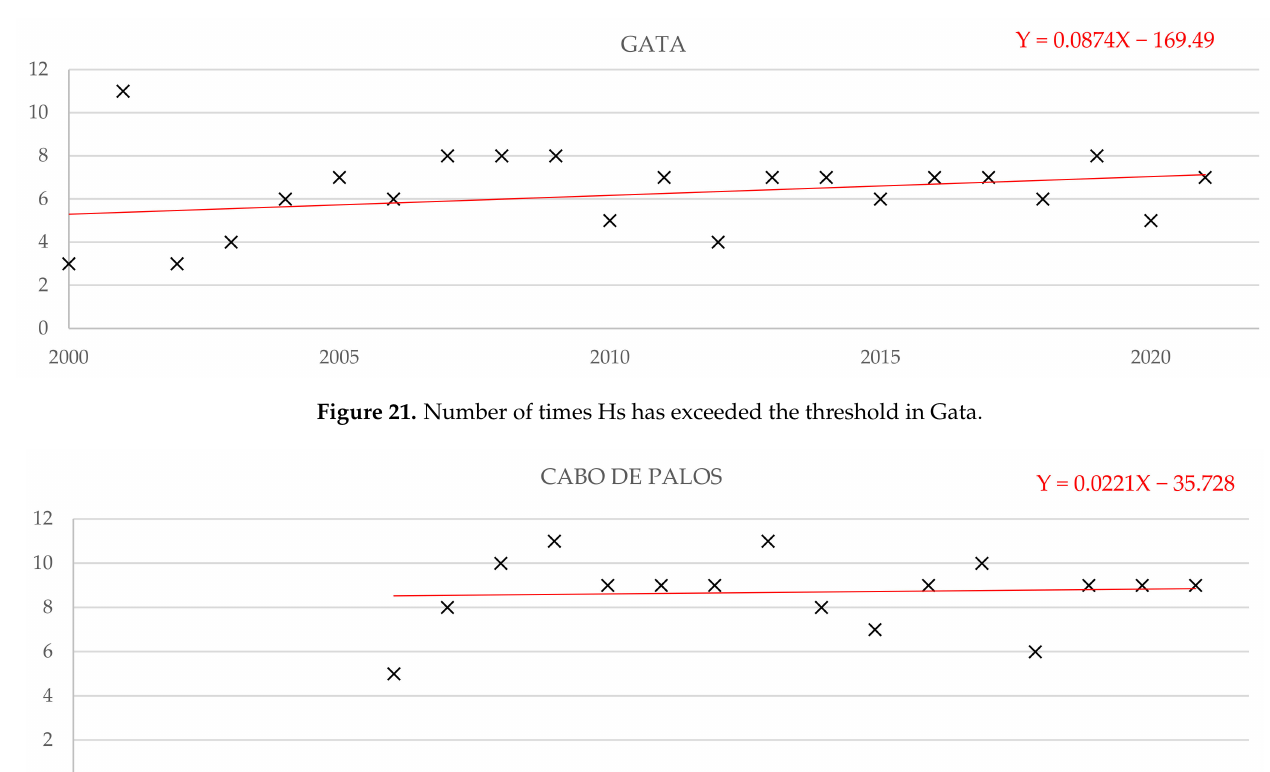
Figure 20. Number of times Hs has exceeded the threshold in Alboran.